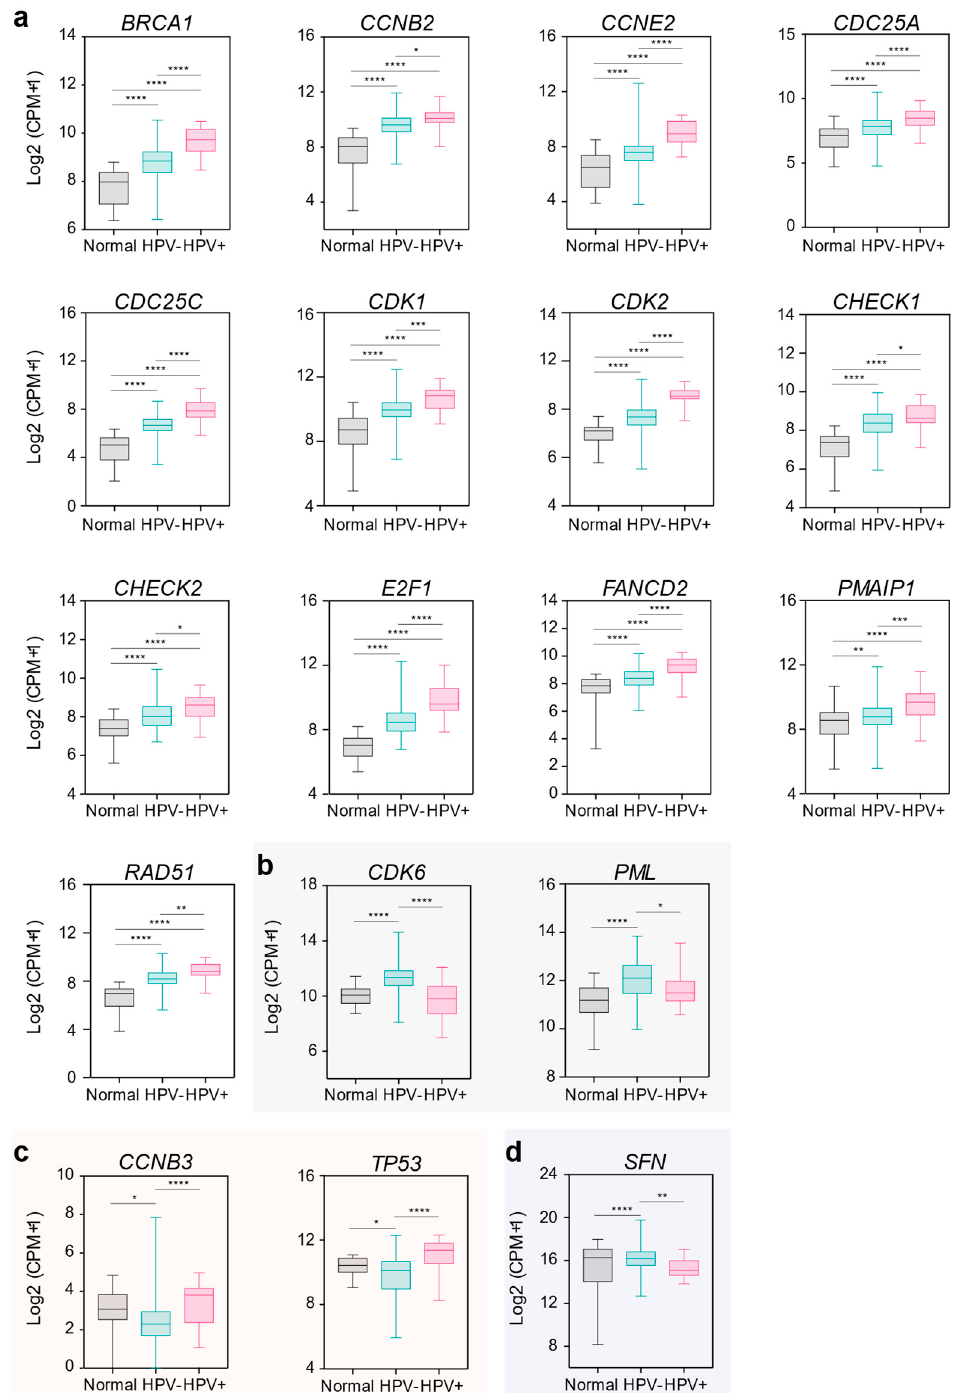
Figure 3. DDR gene expression correlation with HPV infection in OSCC patients. ( a – d ) Box plots showing the correlation between mRNA expression and HPV infection. HPV − (negative for HPV infection); HPV+ (positive for HPV infection). Normal (normal tissue) n = 32, HPV − n = 271, HPV+ n = 26 (Supplementary Tables S1 and S3). One-way ANOVA for multiple comparisons. * p < 0.05, ** p < 0.01, *** p < 0.001, **** p < 0.0001. Groups without statistical significance were unmarked. CPM; counts per million mapped